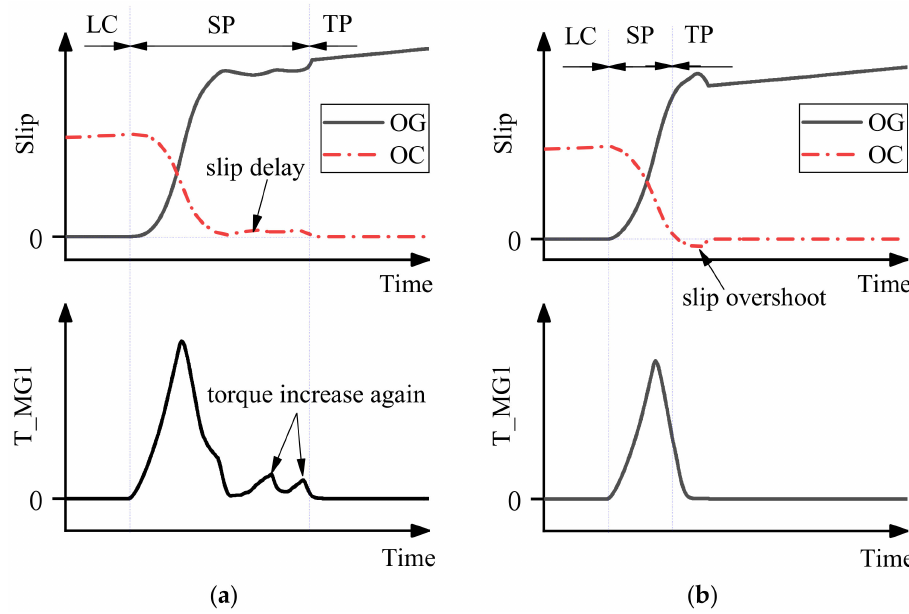
Figure 7. The shifting phenomenon with abnormal P 2 . ( a ) P 2 is too high; ( b ) P 2 is too